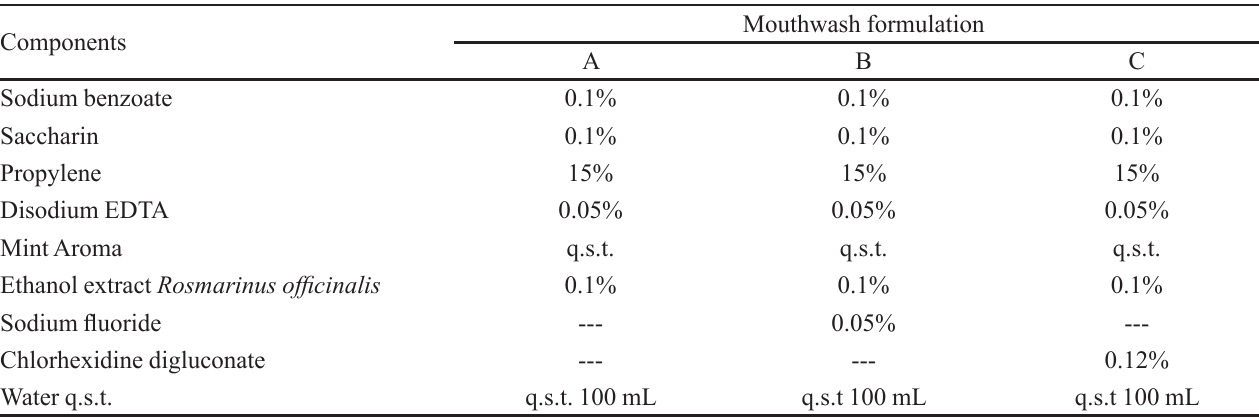
TABLE I - Mouthwash formulation with ethanol extract of R. officinalis